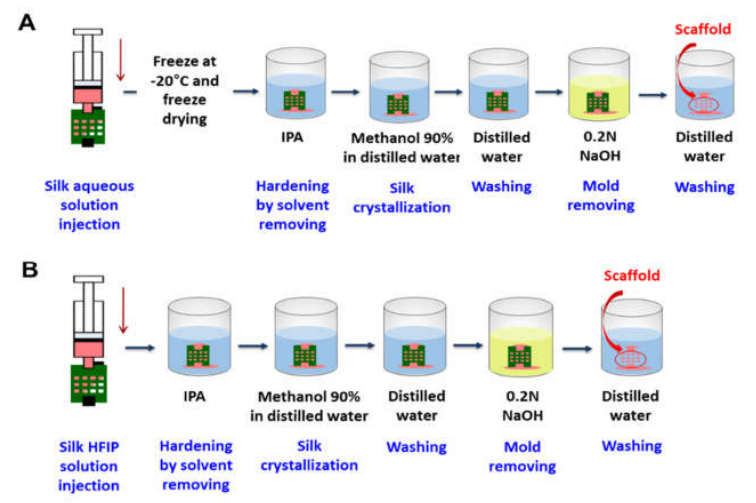
Figure 3. Schematic diagrams of the sacrificial molding process and SF scaffold fabrication depending on the solvent: ( A ) water and ( B ) HFIP.